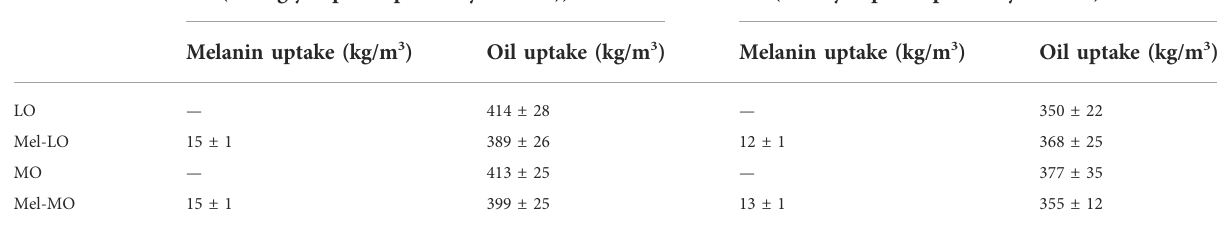
TABLE 2 Uptake of melanin and natural oils in walnut wood.